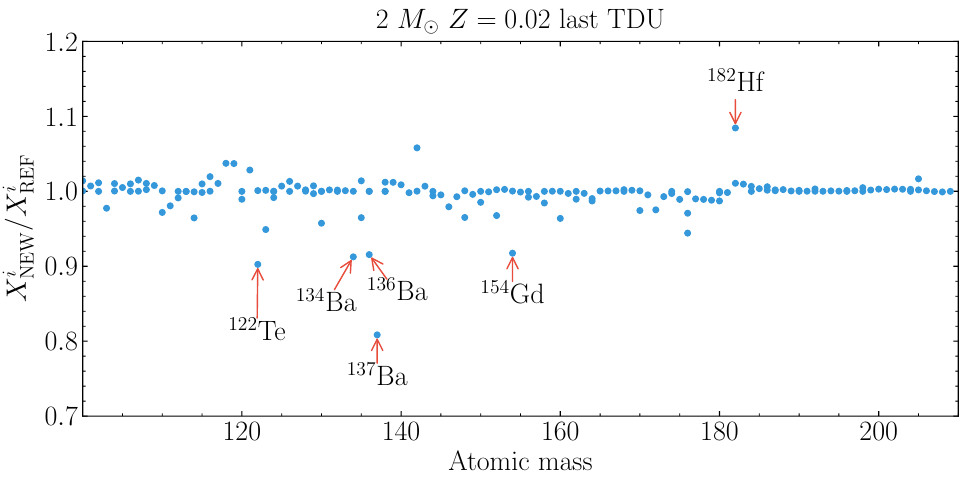
and metallicity (cid:12)